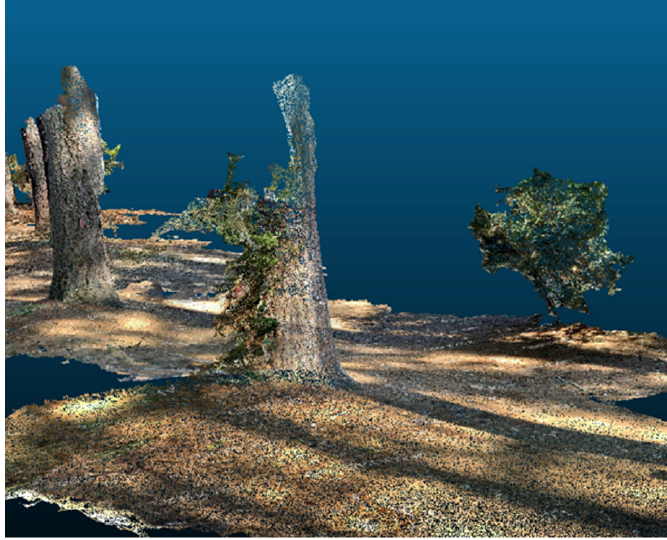
Figure 21. Low ground vegetation around the tree base blocking the view of iPad LiDAR sensor.